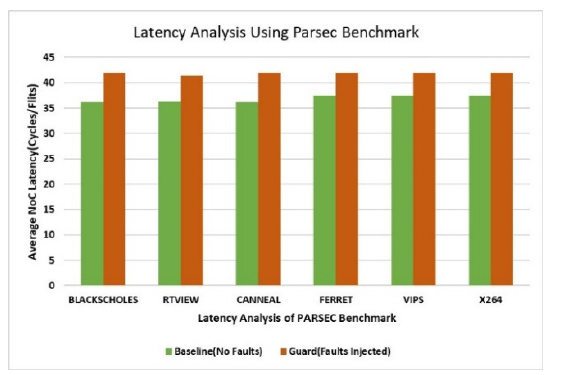
FIG. 20: Latency Analysis for